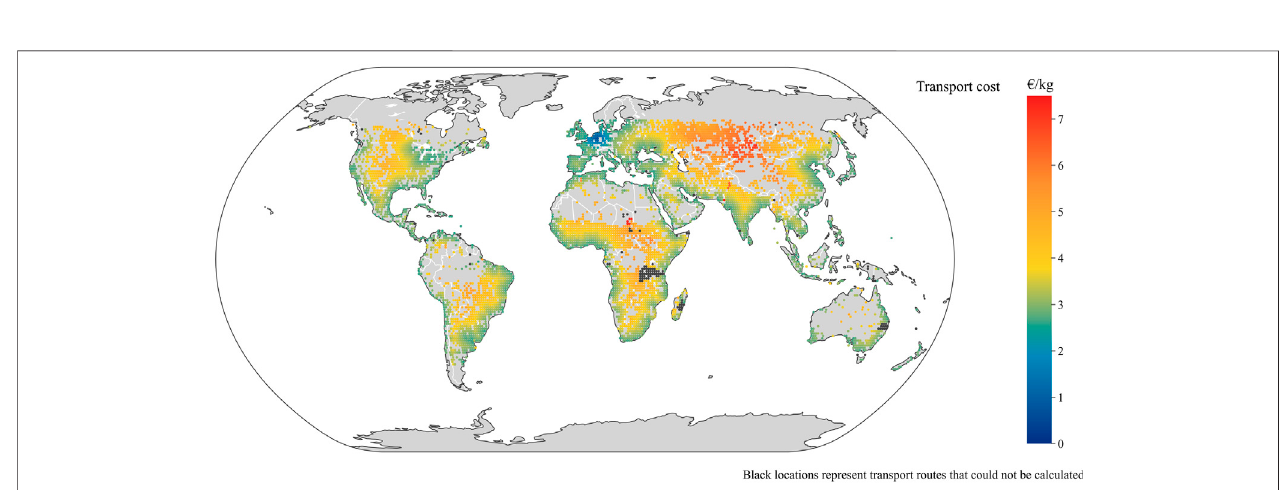
FIGURE 6 | The transport cost of H 2 to Cologne, Germany, in the baseline scenario (100 kt/y AE electrolyser in 2030, centralised reconversion), from each of the 5970 selected global locations. Black dots represent locations where possible transport routes could not be found. Pipelines are not considered in this scenario. All transport mediums are considered. Results are from a Monte Carlo simulation with 1,000